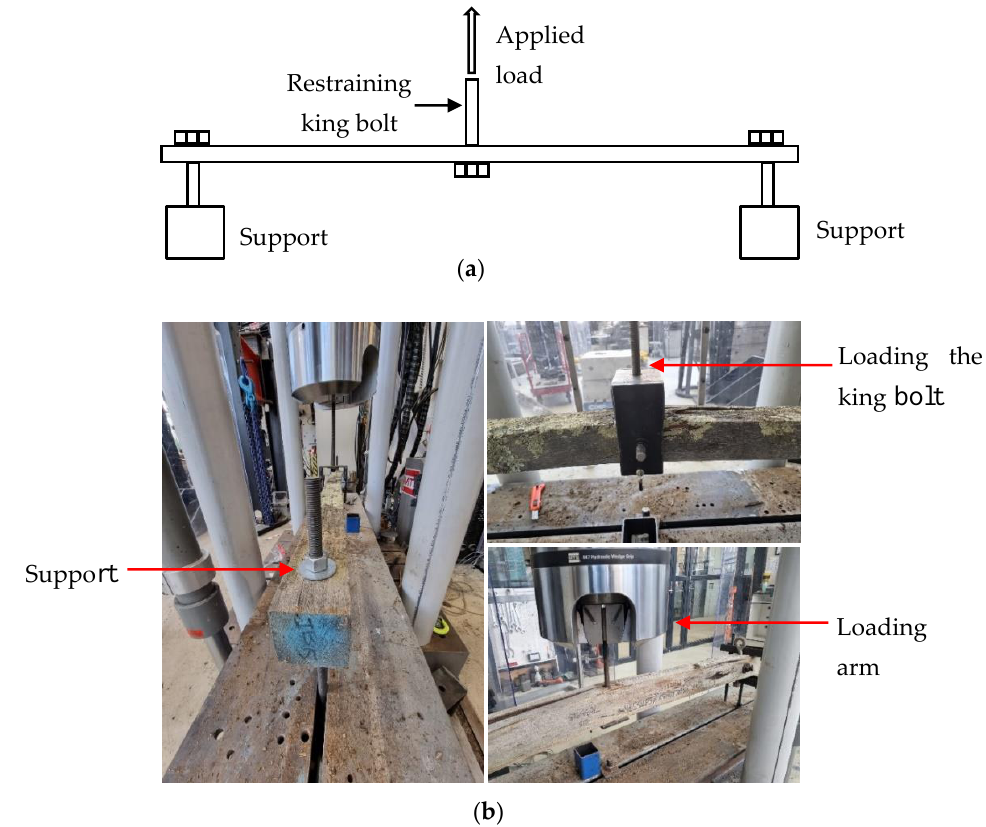
Figure 5. Three-point bending test setup: ( a ) schematic representation; ( b ) actual test setup.